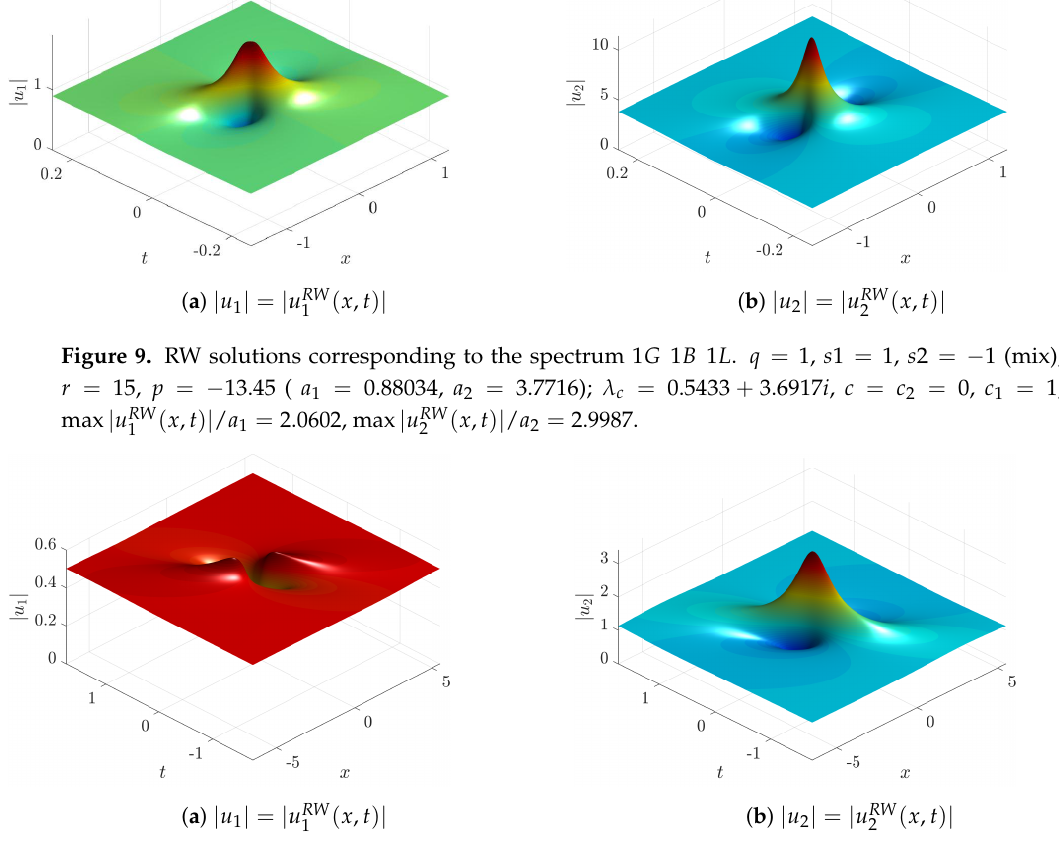
Figure 10. RW solutions corresponding to the spectrum 0 G 2 B 1 L . q = 1, s 1 = s 2 = − 1 (focussing), r = 1, p = − 1.5 ( a 1 = 0.5, a 2 = 1.118); λ c = 0.45209 + 1.1448 i , c = c 2 = 0, c 1 = 1,